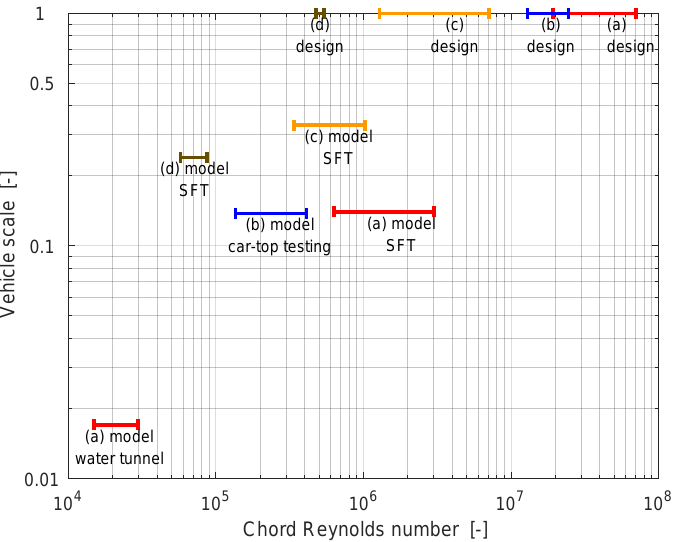
Figure 2. Wing mean-chord Reynolds number achieved by different subscale models (’model’) and testing techniques at sea level, compared to the nominal design values (’design’) of the respective full-scale concepts of Table